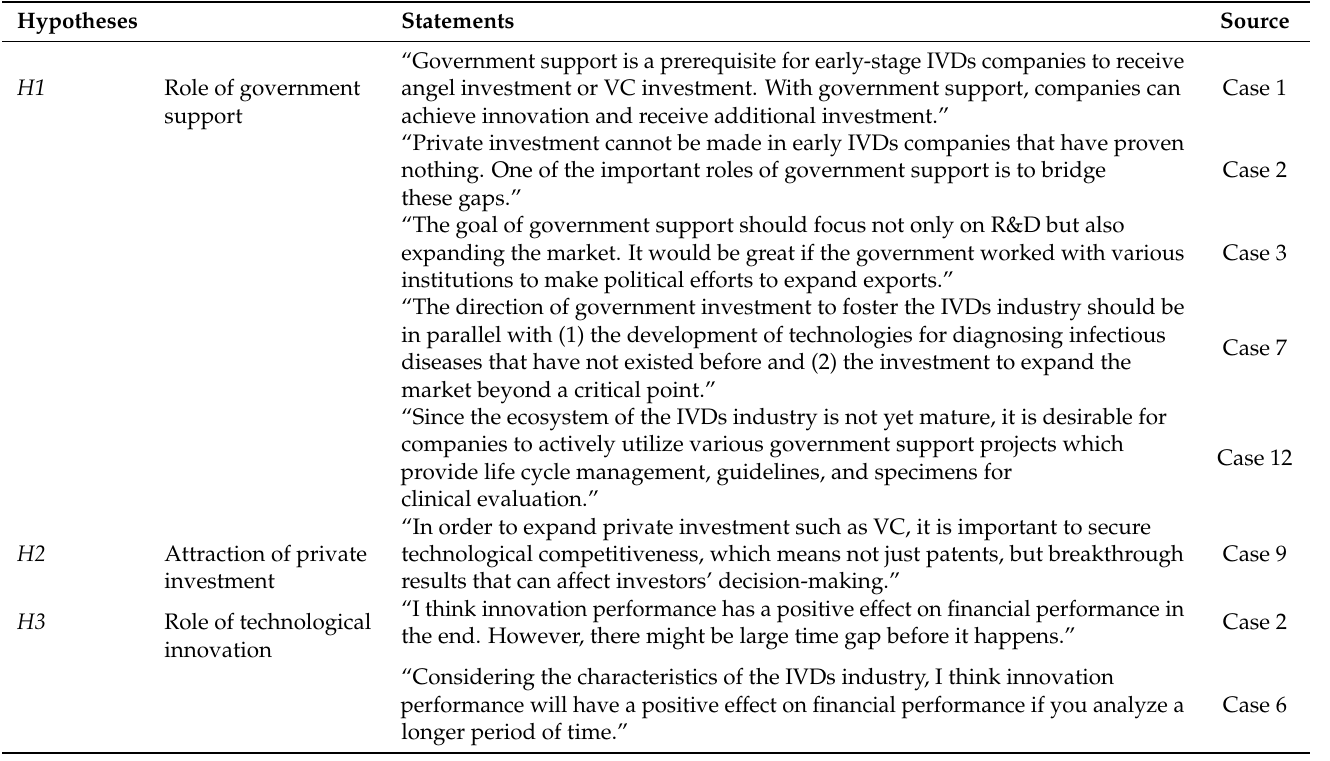
Table 5. Experts’ statements on hypotheses and empirical